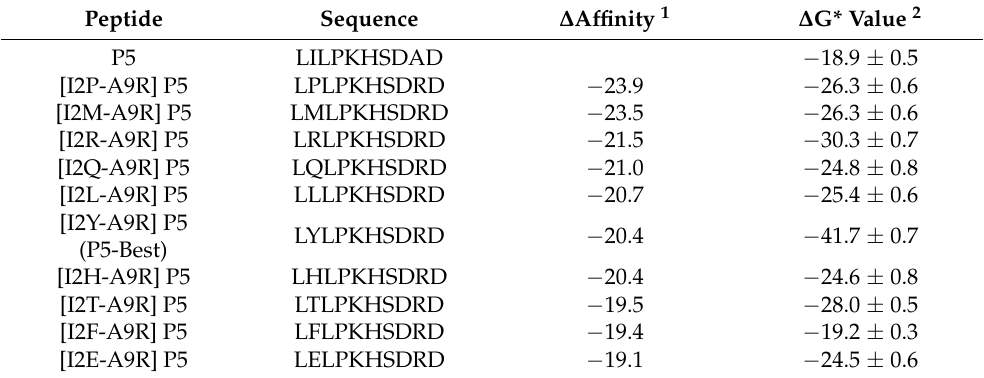
Table 2. Estimated binding affinity values of newly designed P5 analogs (columns 1–2), calculated by Prime software ( ∆ Affinity, column 3) and standard MD/MM-GBSA calculations ( ∆ G* values, column 4). Peptide Sequence ∆ Affinity 1 ∆ G* Value 2 P5 LILPKHSDAD − 18.9 ±